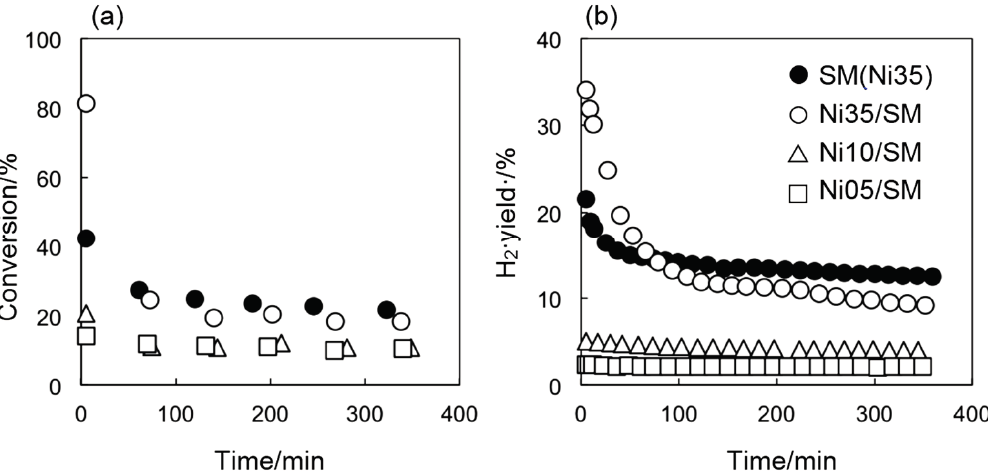
Figure 6. Time profiles of total conversion ( a ) and H 2 yield ( b ) over different Ni catalysts at 500